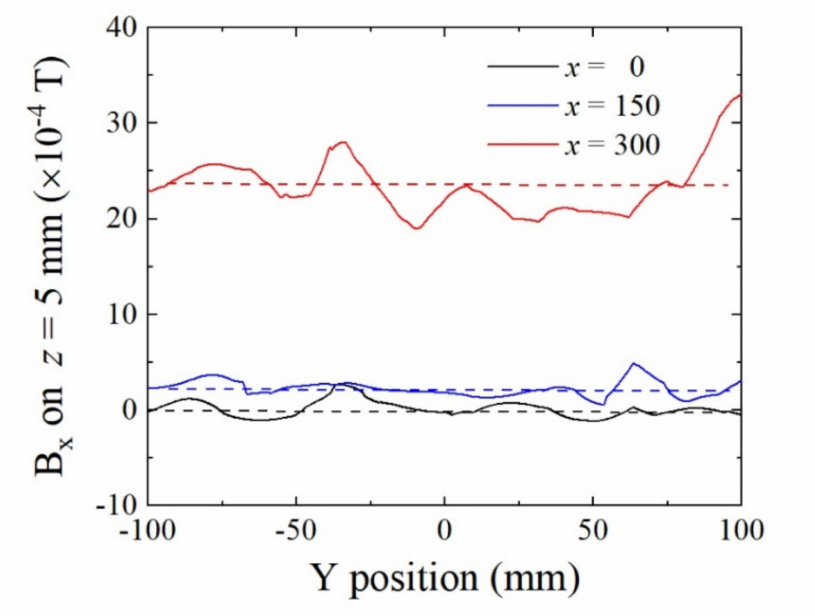
Figure 13. Simulated variations in transverse magnetic flux density B x on Y-position at the sensor height z = 5 mm as a parameter of transverse position X. (Unit of x :